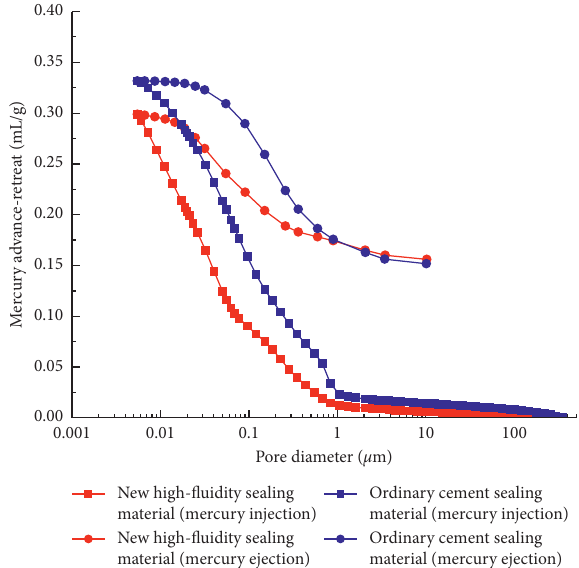
Figure 10: Relationship between mercury volume and pore size of different